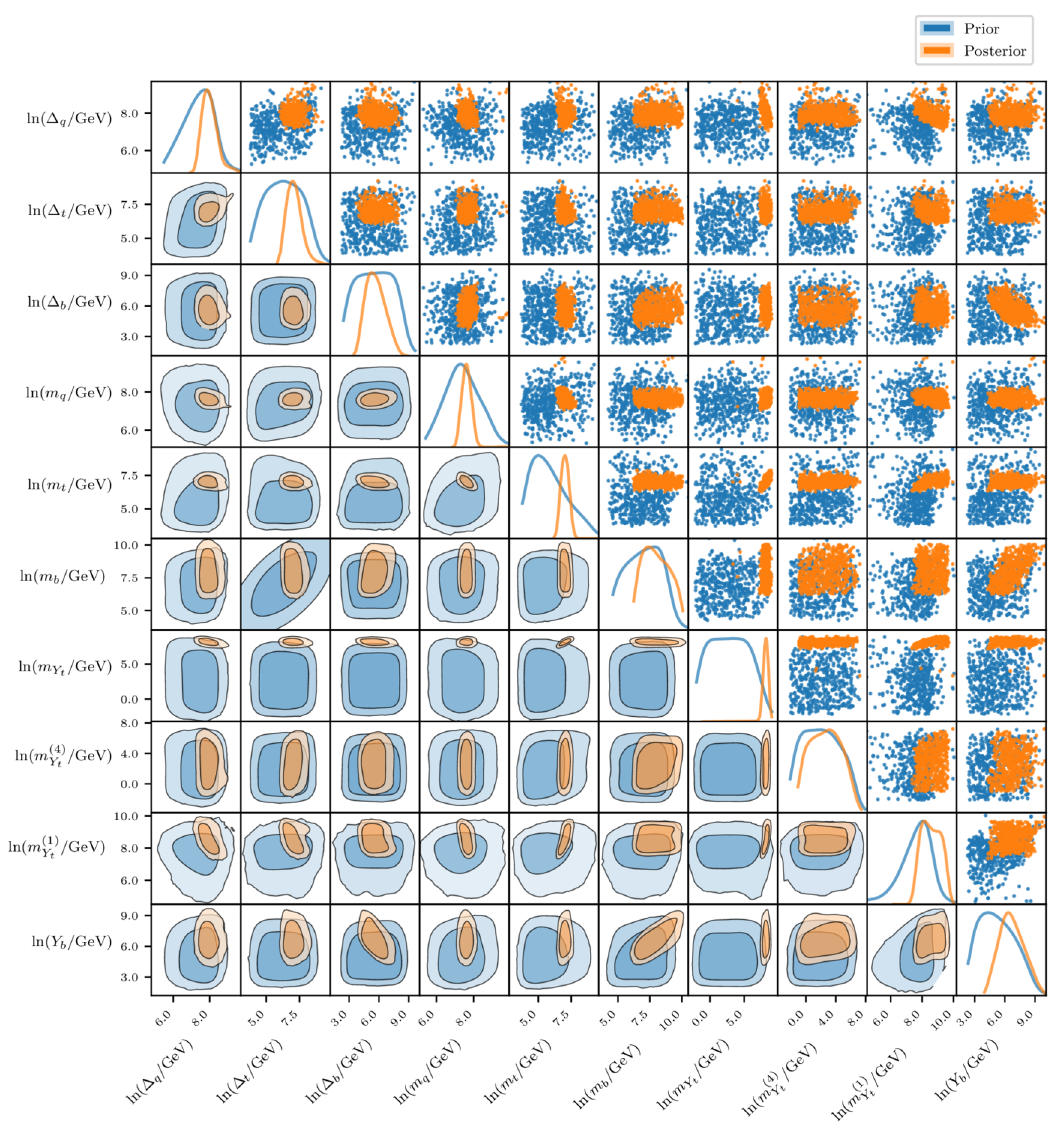
Figure 7. 1D and 2D marginalised priors and posteriors for the fermion sector parameters in the M4DCHM 14 − 14 − 10 . The parameters m (4)